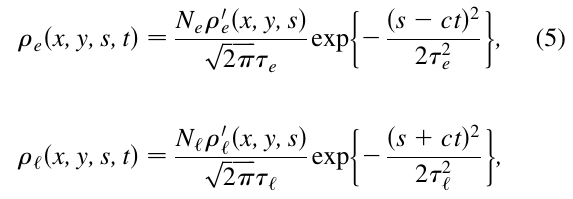
FIG. 16. (Color) Result of the position scan: (a) for the hori- (cid:2) 44 (cid:6) m ; (b) for the vertical direction, zontal direction, # x (cid:2) 25 (cid:6) m . # y